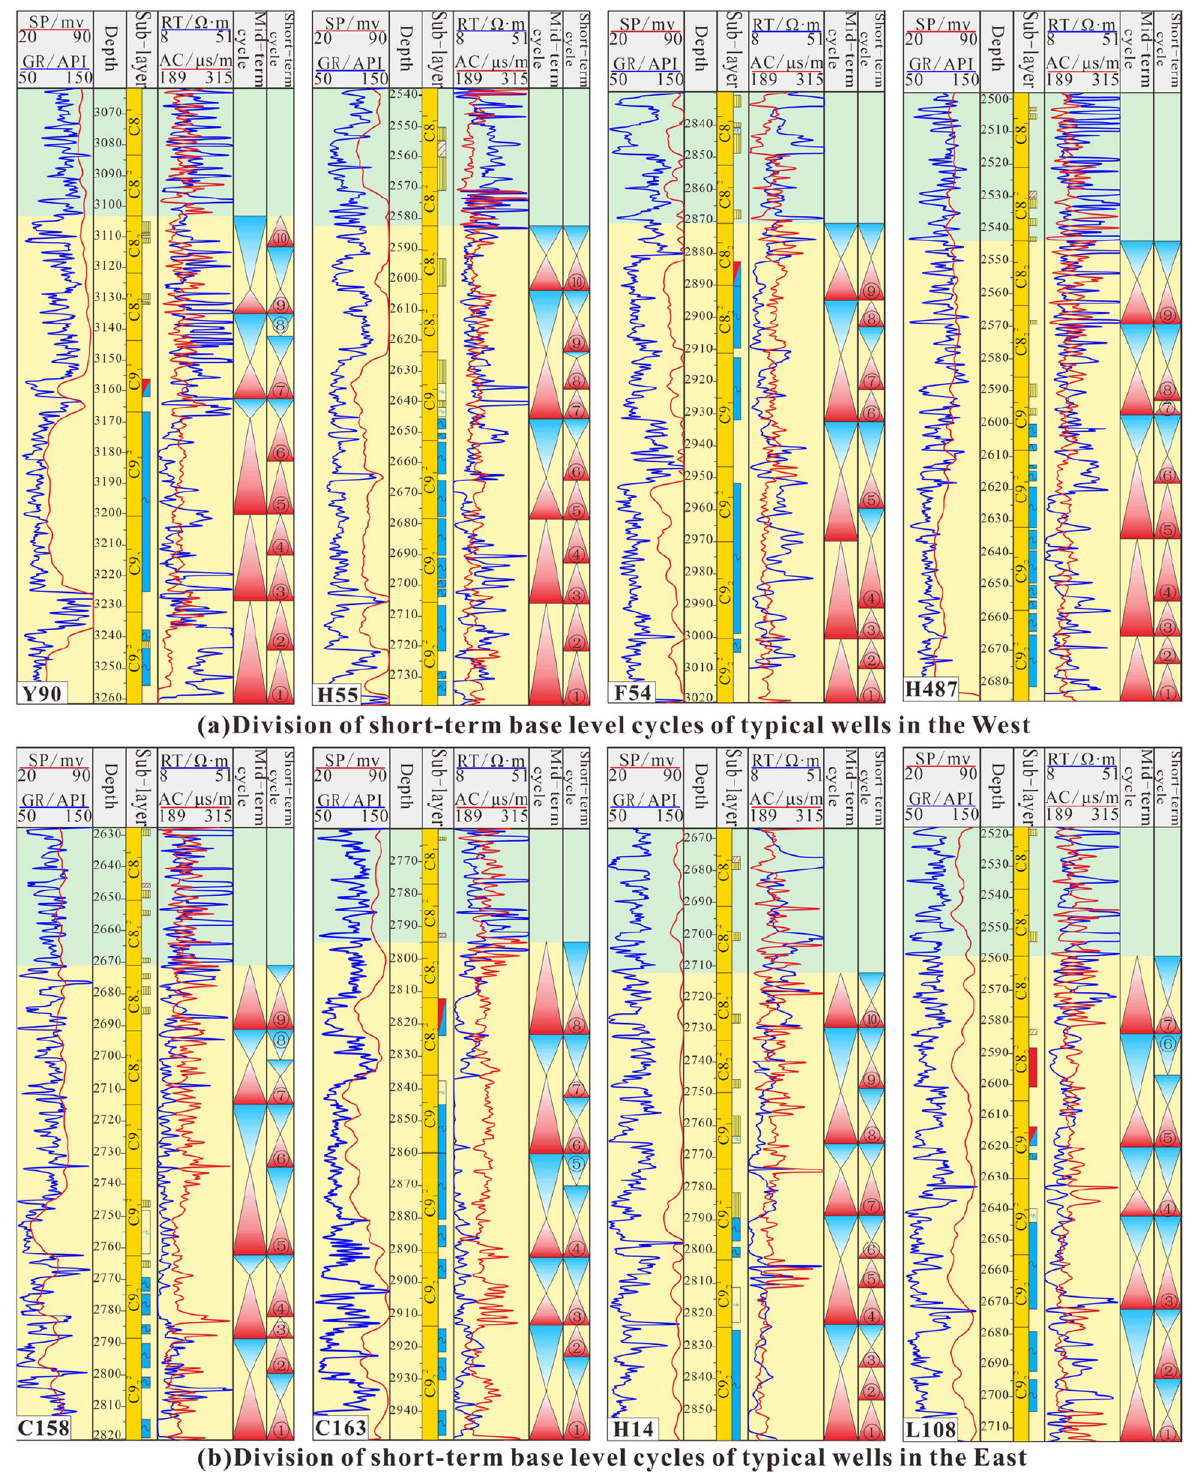
Figure 9. Results of short-term base level division in the study area (Note: SP, GR, RT and AC are abbreviations of logging curve names. SP represents the spontaneous potential curve, GR represents the natural gamma curve, RT represents the resistivity curve, and AC represents the interval transit time curve. Short-term cycles are represented by the symbols ① – ⑩